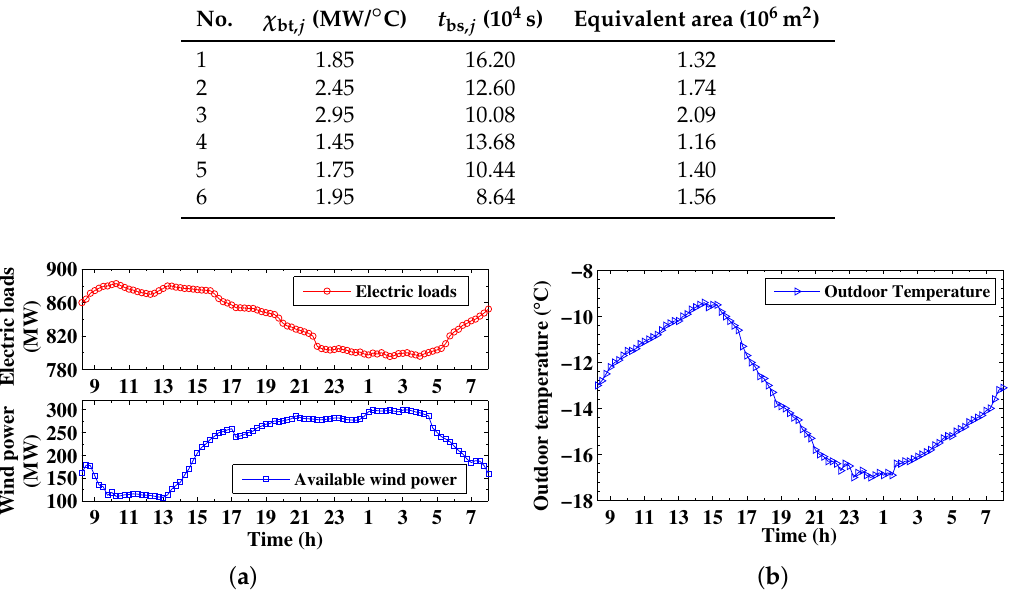
Table 3. Parameters of buildings.